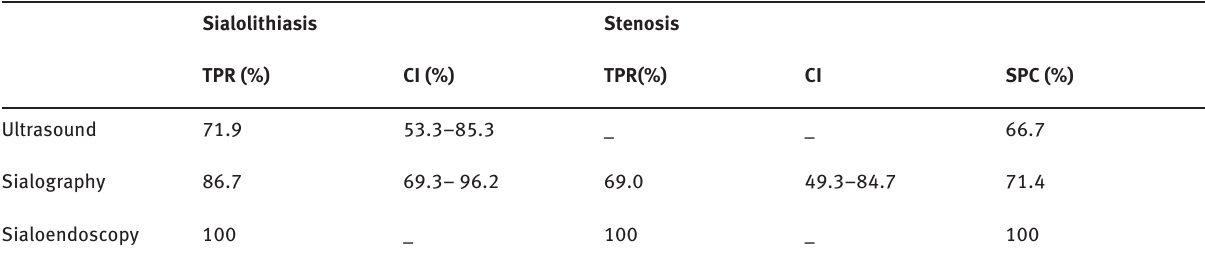
Table 1: Sensitivity and specificity of ultrasound, sialography, and sialoendoscopy (N=79). Sialolithiasis